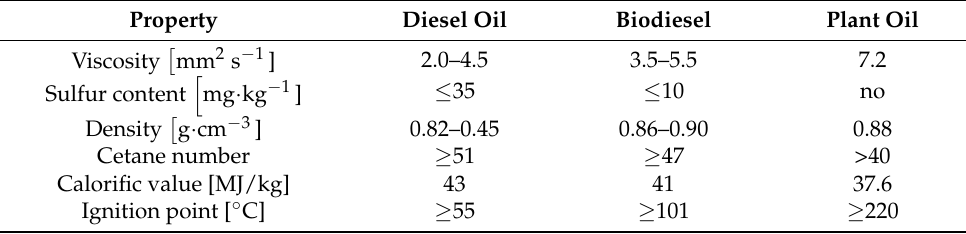
Table 1. Physical chemical properties of fuels used in combustion